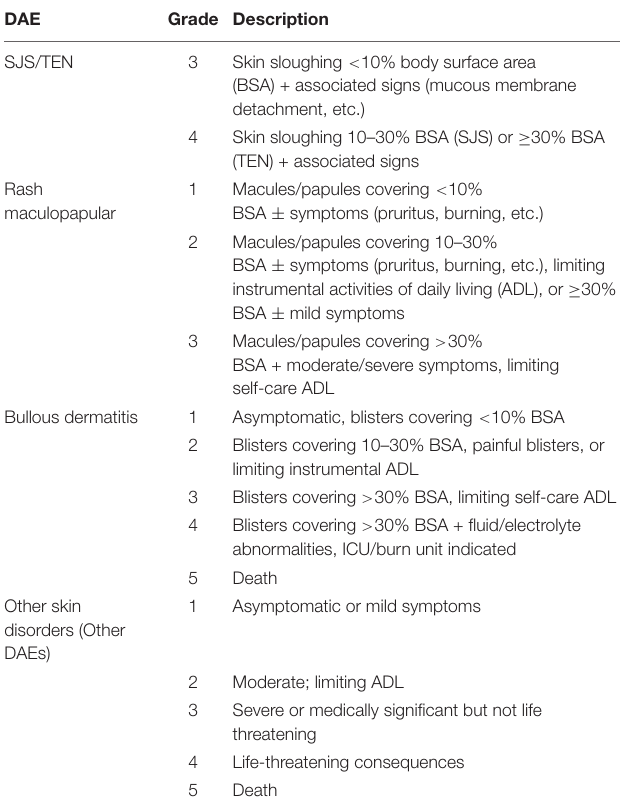
TABLE 1 | DAE grading (Adapted from the CTCAE Version 5.0) (6). DAE Grade Description